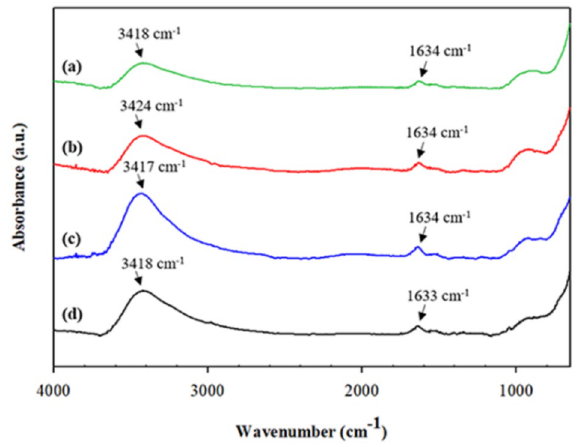
Figure 3. FT-IR spectra of the CoFe 2 O 4 under various surfactant types: ( a ) CoFe 2 O 4 _SDS_1CMC; ( b ) CoFe